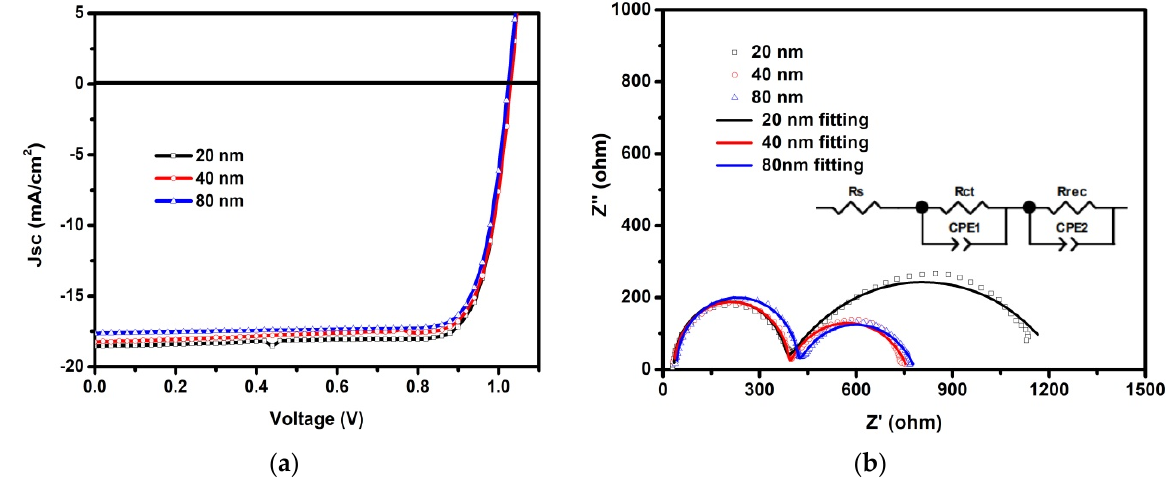
Figure 3. ( a ) J - V characterizations of the 1 M device with different thicknesses (20, 40, 80 nm) of C 60 ETL. ( b ) Nyquist plots of 1 M devices with the above different thicknesses of C 60 ETL. The inset is the equivalent circuit used for fitting.